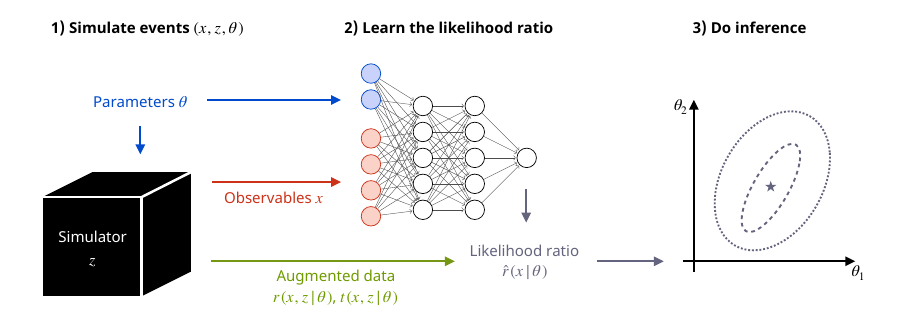
Figure 1. The likelihood ratio r ( x | θ ) can be approximated with a neural network by minimizing a suitable loss function which makes use of the joint likelihood ratio r ( x , z | θ ) and the joint score t ( x , z | θ ) extracted from the simulators. Inference can then be performed directly with the approximation ˆ r ( x | θ